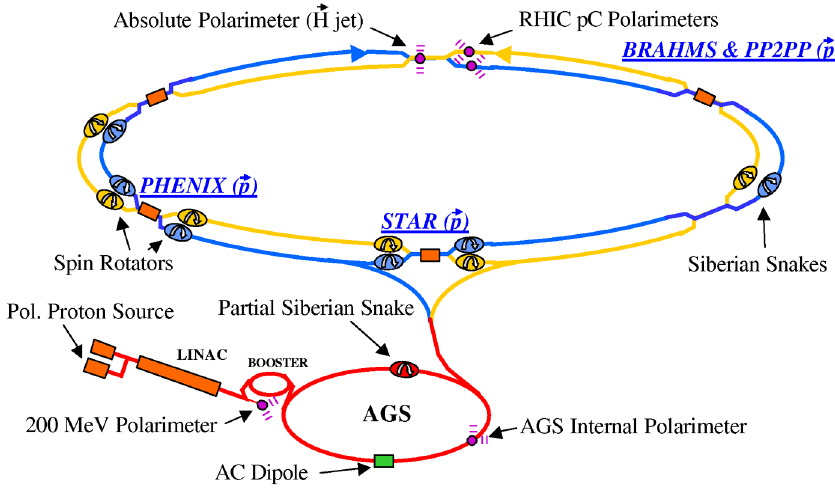
FIG. 2. (Color) The Brookhaven polarized proton facility complex, which includes the optically pumped polarized ion source (OPPIS), 200 MeV linac, the AGS Booster, the AGS, and RHIC. The absolute polarimeter in RHIC will be installed in